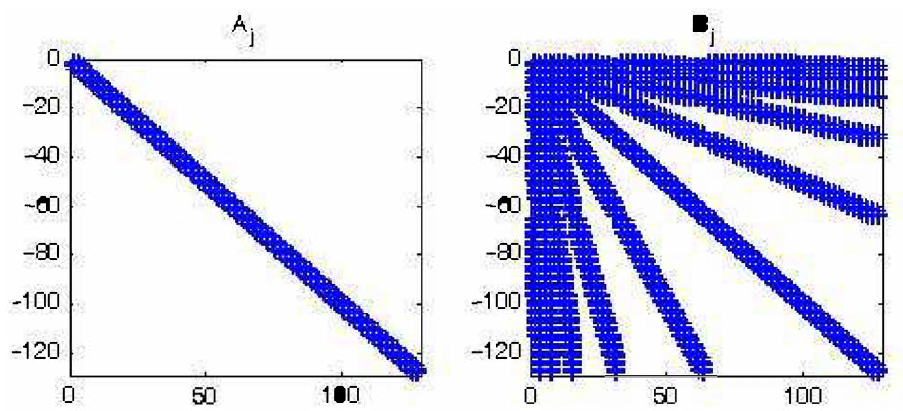
Figure 1. The pattern of the stiffness matrix A j ( left ), B j ( right ) for j = 7.